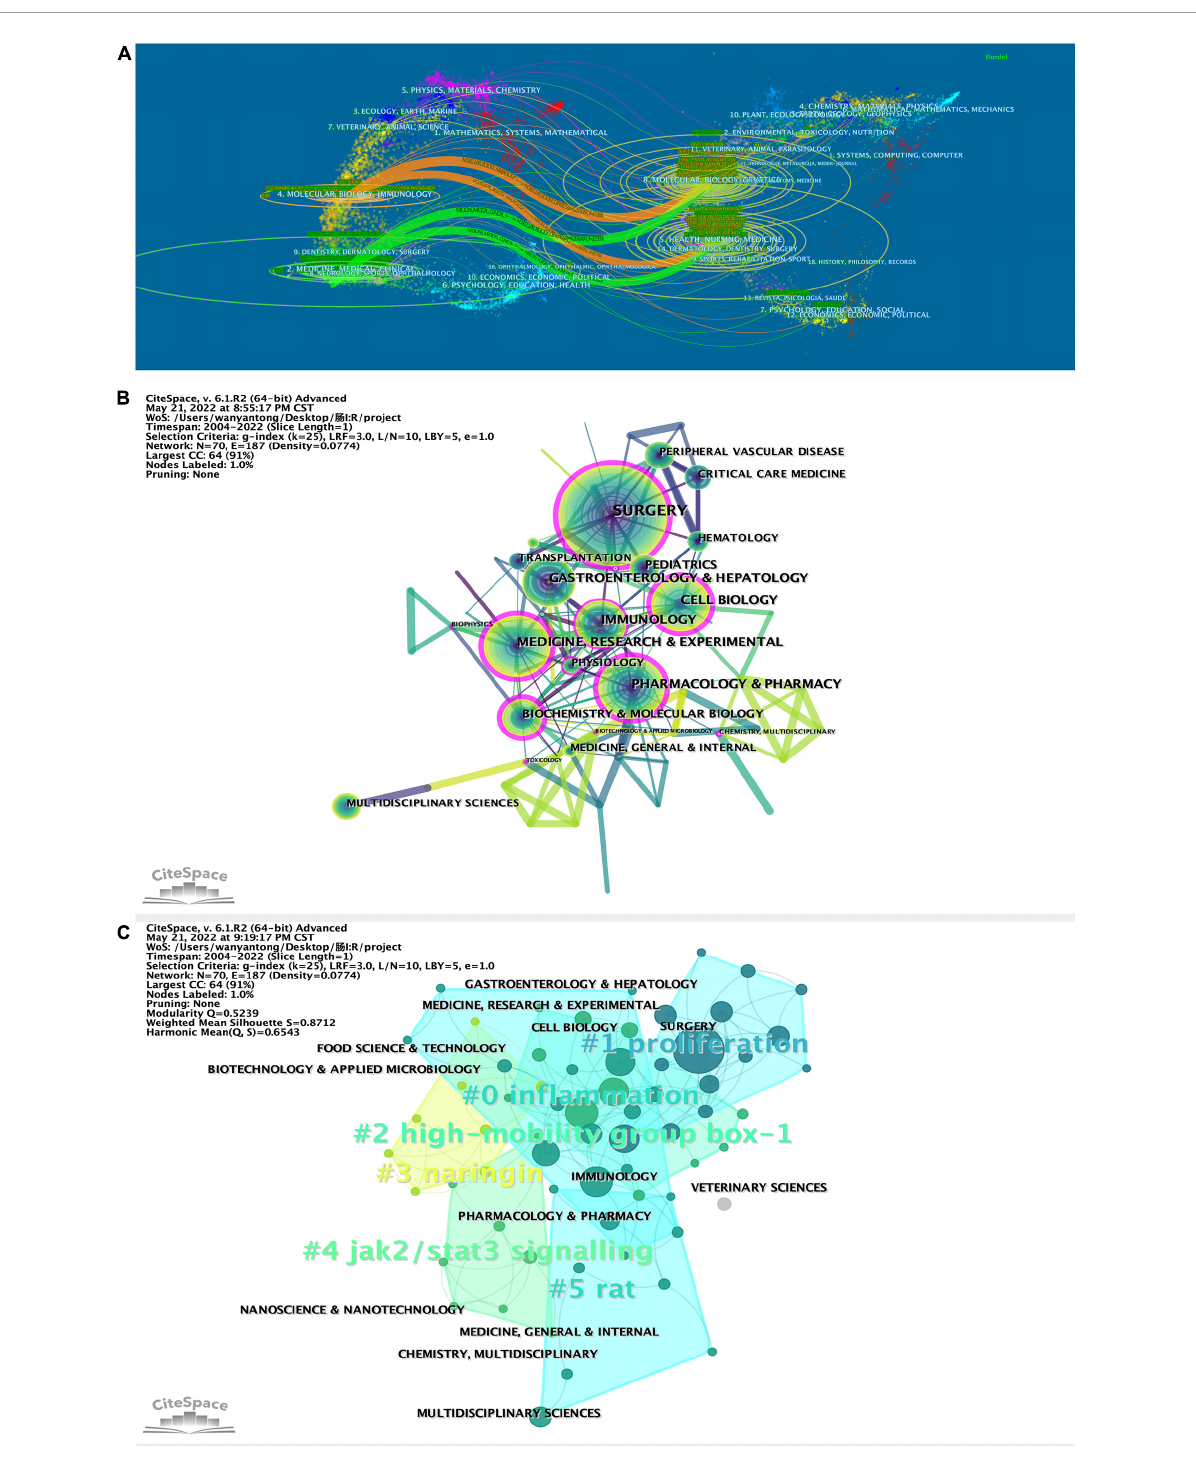
FIGURE6 (A) Biplot of published and cited literature journals, with published journals on the left and cited journals on the right. CiteSpace was applied to analyze (B) the citation relationship between the subject areas in which the literature was published and (C) clustered. Sizes of nodes represent publications of subject in (B) and (C) . The betweenness centrality of a node in the network measures the importance of the position of the node in the network, in (B) . Clustering module value (Q value), using in CiteSpace cluster analysis, it is generally considered that Q > 0.3 means that the clustering structure is significant, shown line 10 in top left of (C) . The average contour value of clustering (S value), in line 11, it is generally considered that S > 0.5 clustering class is reasonable and S > 0.7 means that the clustering is